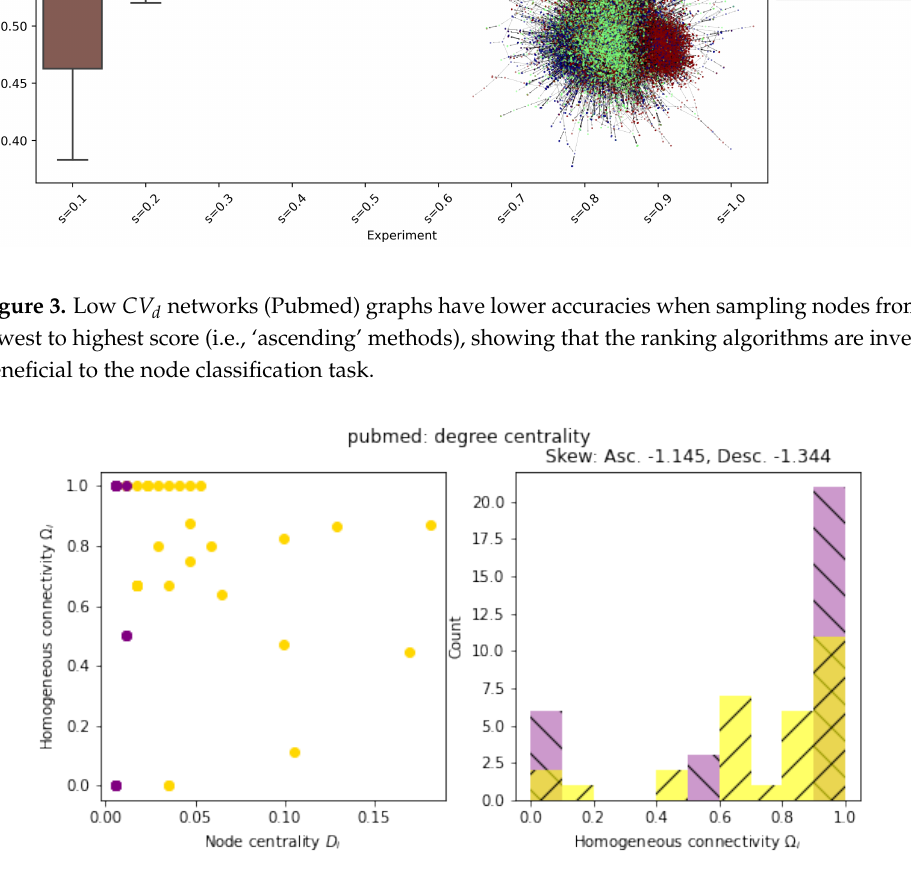
Figure 4. The left figure here presents scatter plots of node degree centrality D i against node homogeneous connectivity Ω i on the training data. The upper half of nodes according to their centrality are colored in yellow while the lower half is presented in purple. The histogram on the right visualizes the distribution of homogeneous connections. The skew for each subset’s distribution is annotated above the right